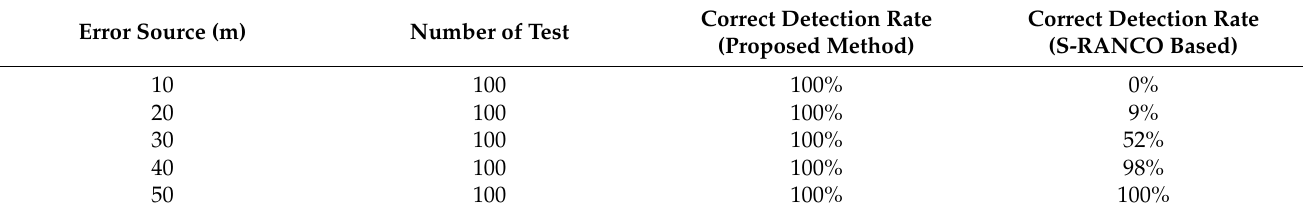
Table 3. Comparison of algorithms performance with various values of error sources in Scenario 2.